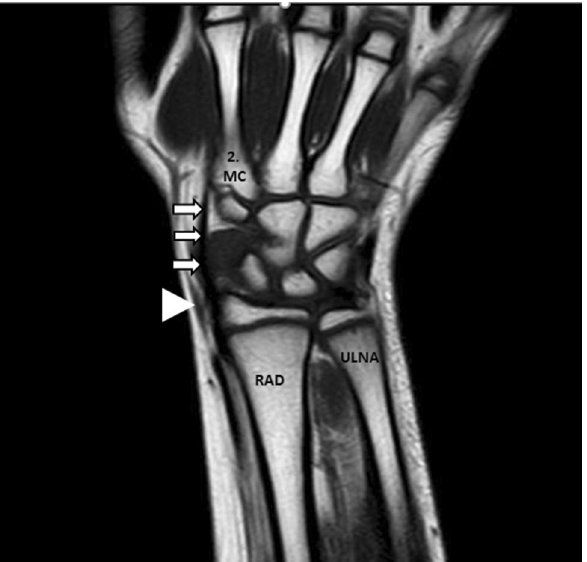
Figure 3. Coronal T1W TSE MR image of the wrist; m. flexor carpi radialis tendon (arrowhead), m. flexor carpi radialis brevis tendon (arrow), radius (RAD), os metacarpale (MC).